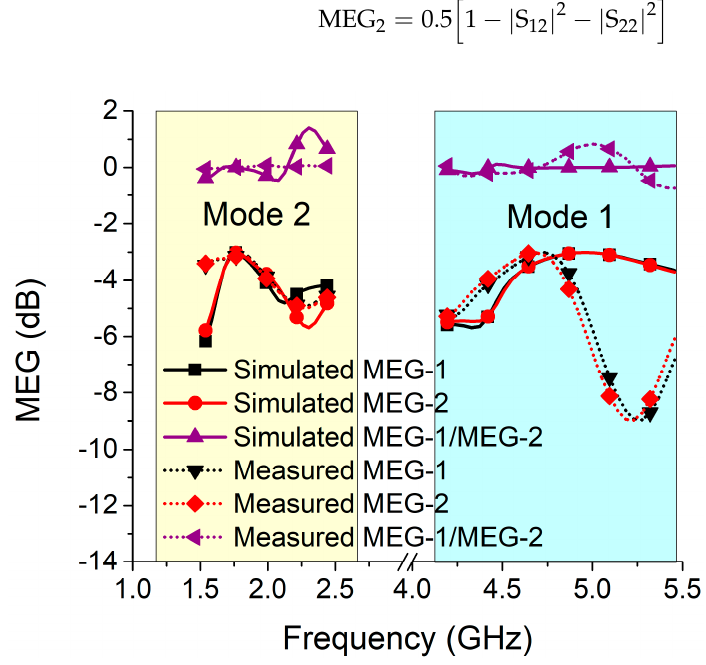
Figure 33. MEG for the MIMO antenna in both modes.